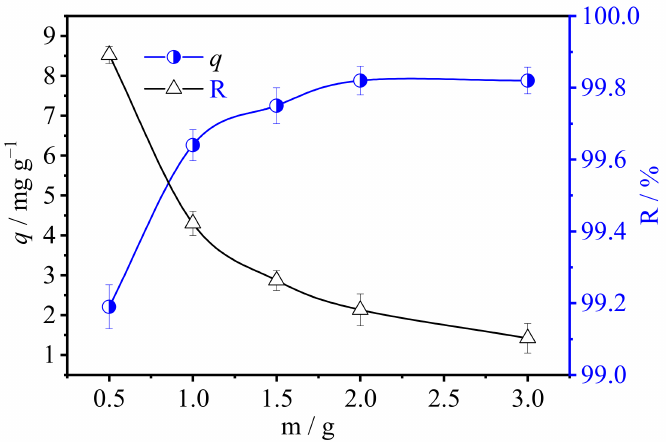
Figure 10. Effect of SAIEF dosage on the adsorption of U(VI) (t = 120 min, C 0 = 50 mg L − 1 , pH = 10.5).